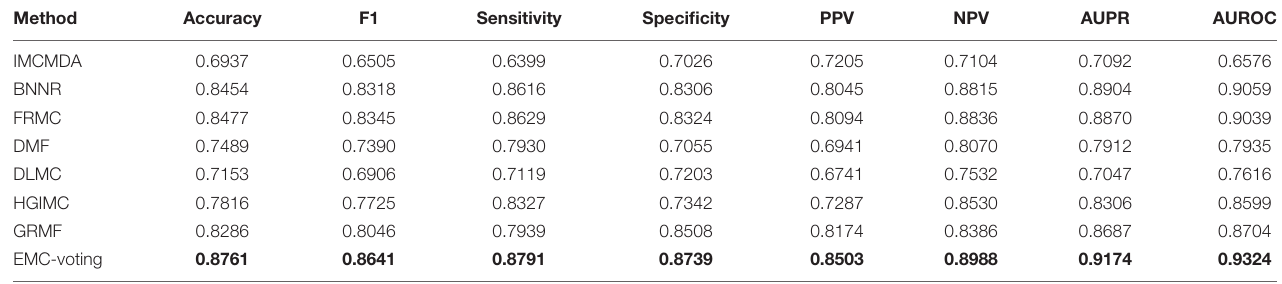
TABLE 4 | Comparison between the EMC-voting model and other matrix completion-based models.